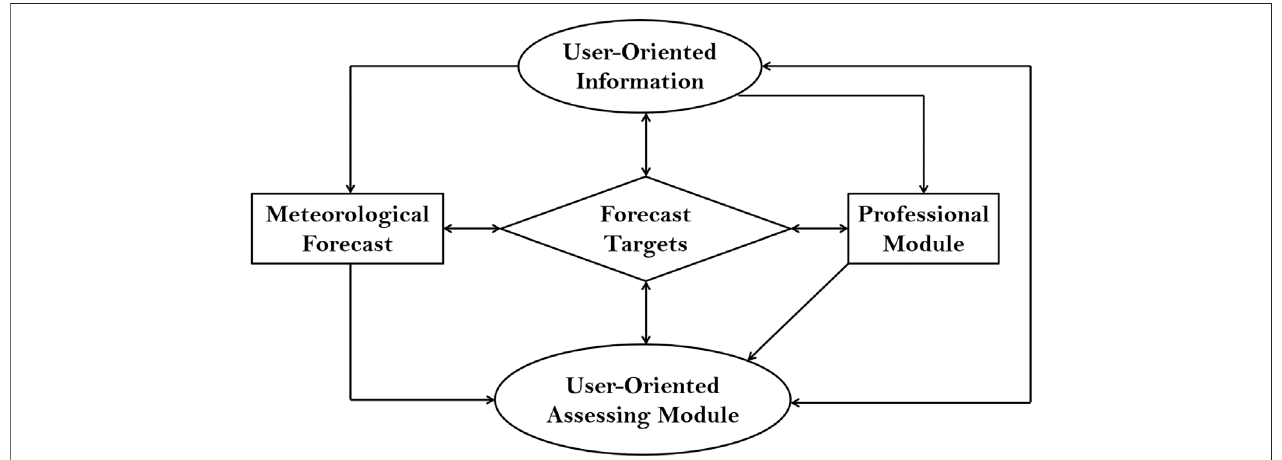
FIGURE 2 | Schematic framework of the